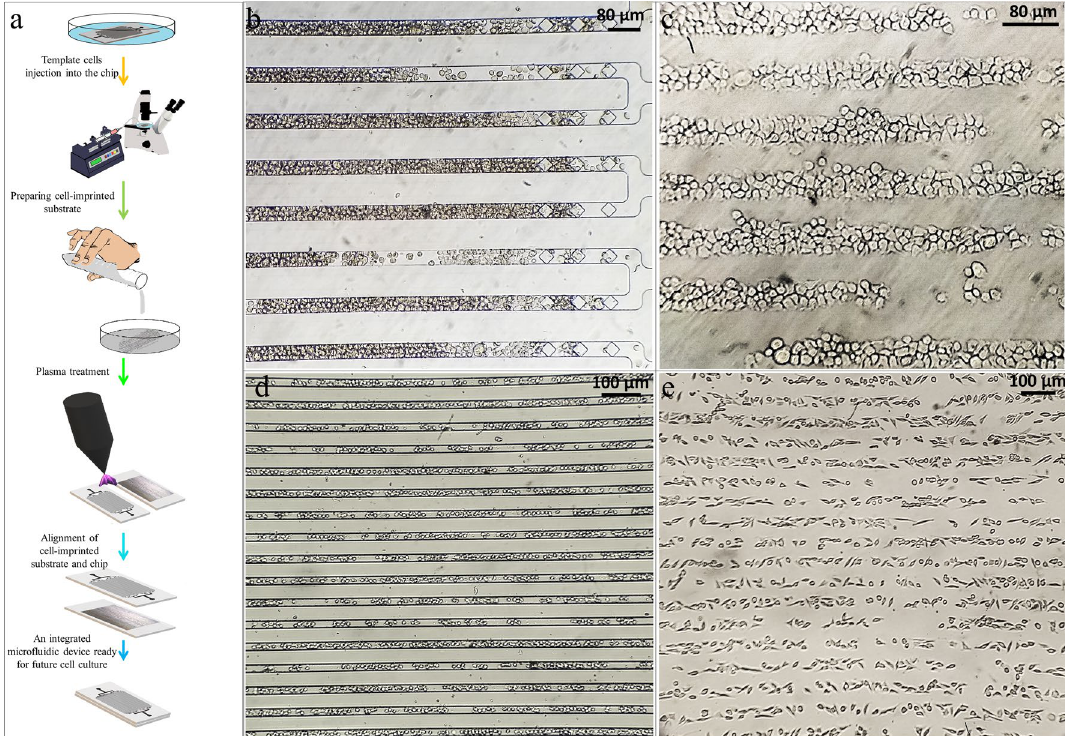
Figure 5. ( a ) The schematic of the cell-imprinted-based integrated microfluidic device fabrication procedure. ( b ) The function of the microfluidic chip in trapping the HUVEC cell line in an area around terminal microposts of 40 µm microchannels of the microfluidic chip, which is almost filled with cells after injection with a syringe pump. ( c ) The regular pattern of HUVEC cell lines transferred to the cell-culture plate. ( d ) 25 µm microchannels of the microfluidic chip are almost filled with L929 cell line after injection with a syringe pump. ( e ) The regular pattern of L929 cell lines transferred to the cell-culture